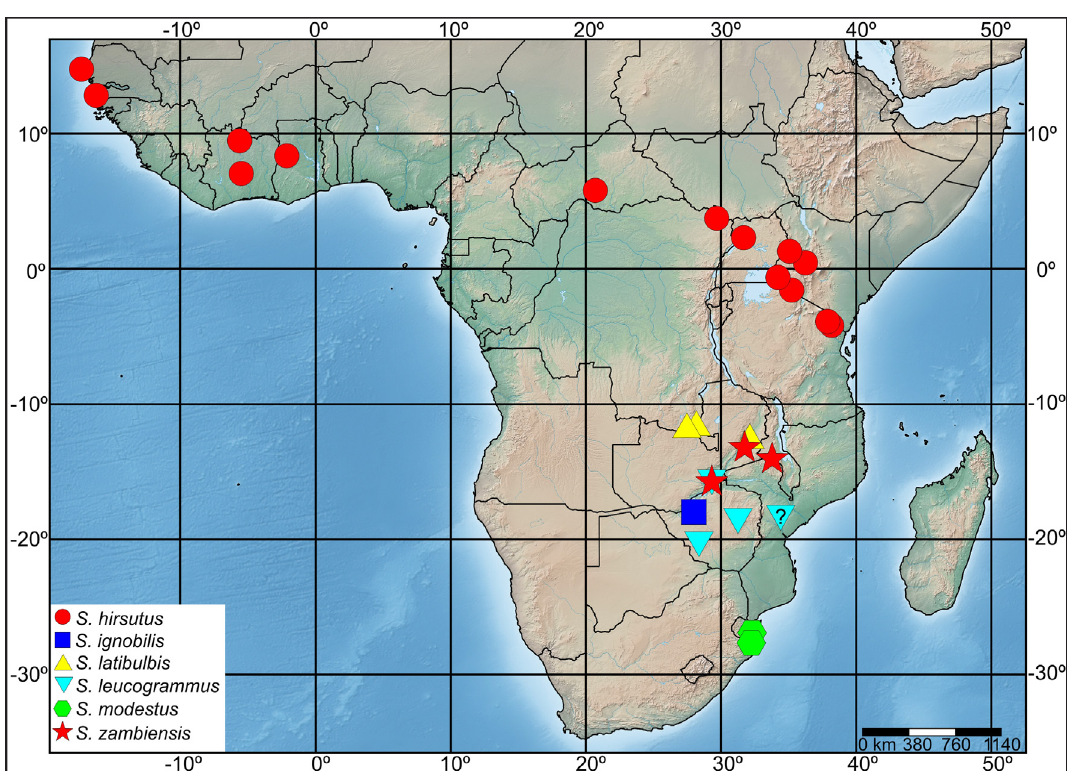
Fig. 513. Collecting localities of six African species of Stenaelurillus Simon, 1885.